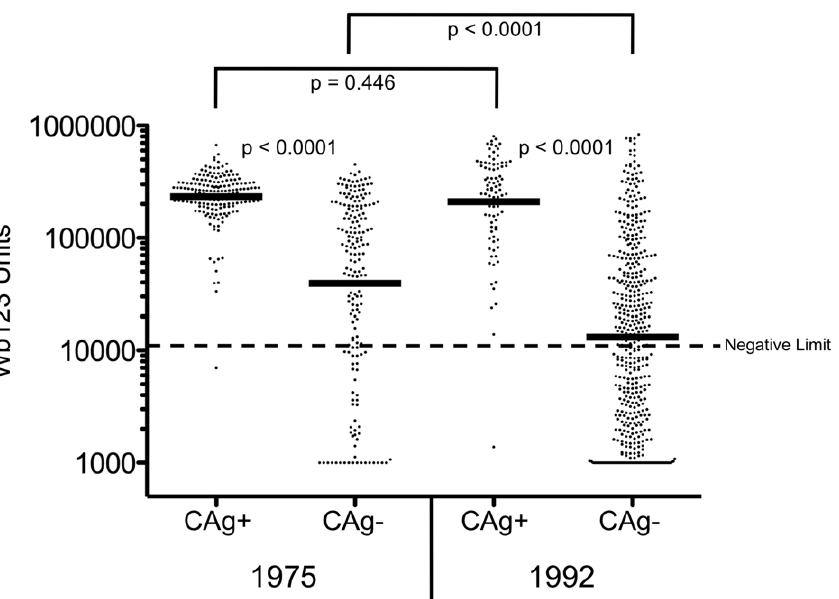
Figure 3. Levels of Ab to Wb123 by CAg Status in 1975 and 1992. Ab levels to Wb123 segregated by CAg status in subjects from 1975 (left side) and 1992 (right side). Each dot represents an individual patient, and the black bars represent the geometric means. The dashed line represents the lower limit of the assay (10,968 units) and p-values were calculated using the Mann-Whitney U test.